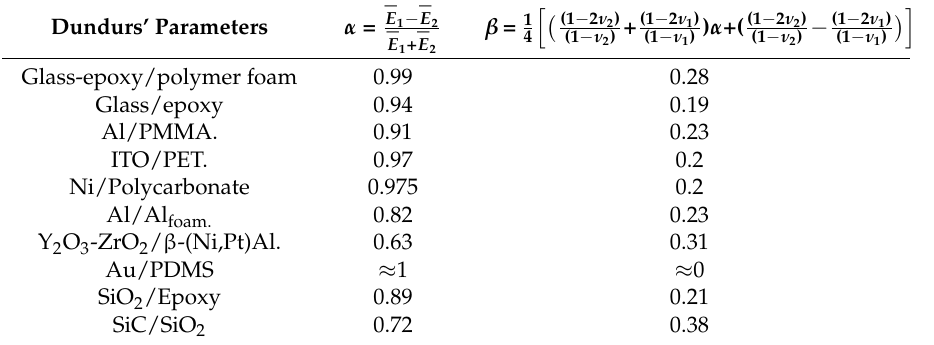
Table 1. Dundurs’ parameters for bi-material interfaces (Mat.#1/Mat.#2) with a large mismatch of the elastic constants (plane strain conditions) [2,3,8,11,33–35]; β is expressed here as a function of α and the Poisson